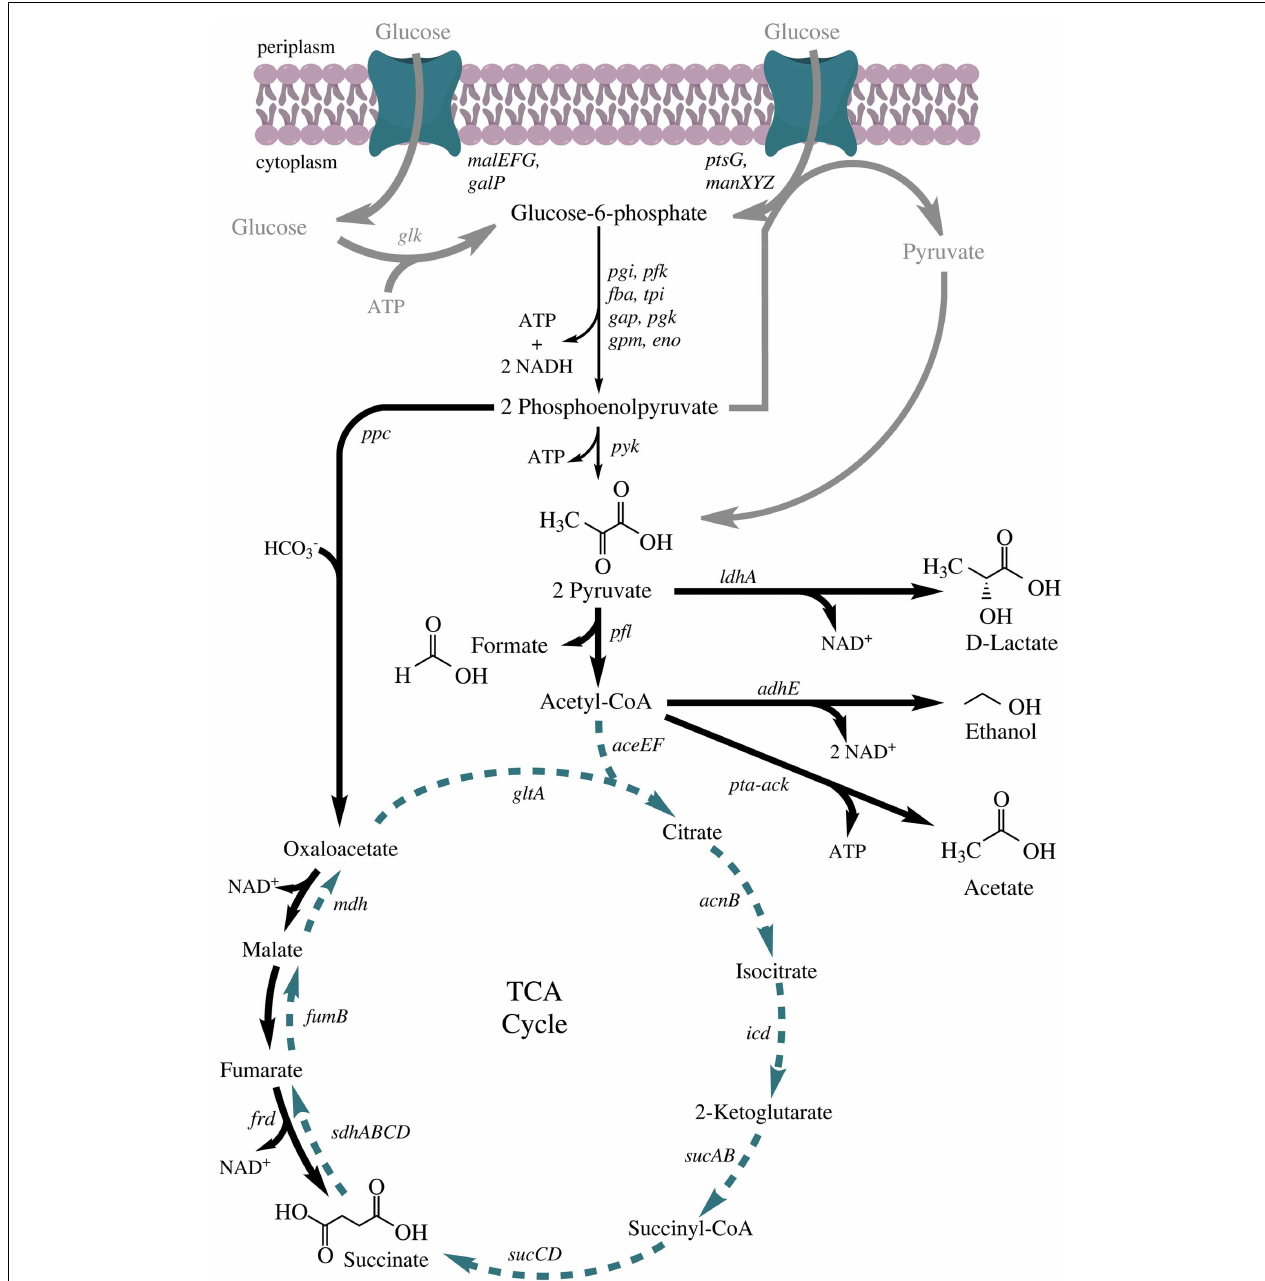
dehydrogenase), pgk (phosphoglycerate kinase), gpm (phosphoglycerate mutase), eno (enolase), pyk (pyruvate kinase), ppc (phosphoenolpyruvate carboxylase), ldhA (lactate dehydrogenase), pfl (pyruvate formate lyase), aceEF (pyruvate dehydrogenase complex), adhE (alcohol dehydrogenase), pta (phosphate acetyltransferase), ack (acetate kinase), gltA (citrate synthase), acnB (aconitase), icd (isocitrate dehydrogenase), sucA (2-oxoglutarate decarboxylase), sucB (2-oxoglutarate dehydrogenase), sucCD (succinyl-CoA synthetase), sdhABCD (succinate dehydrogenase), fumB (fumarate hydratase), frd (fumarate reductase), and mdh (malate